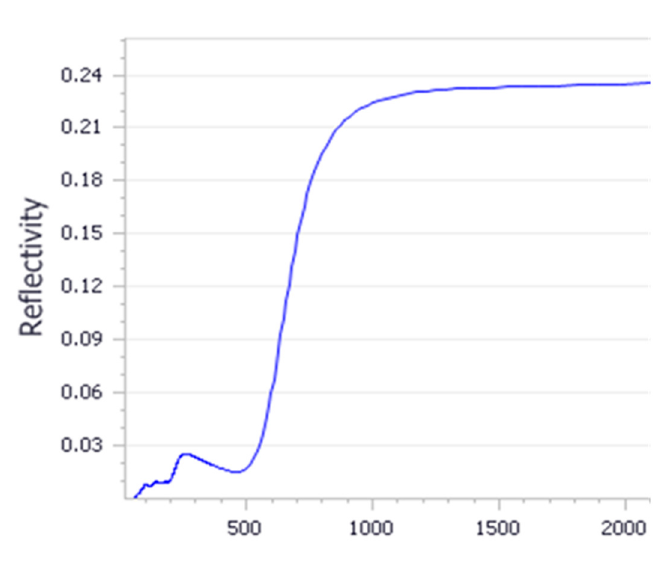
Figure 7. Simulated reflectivity as a function of wavelength.